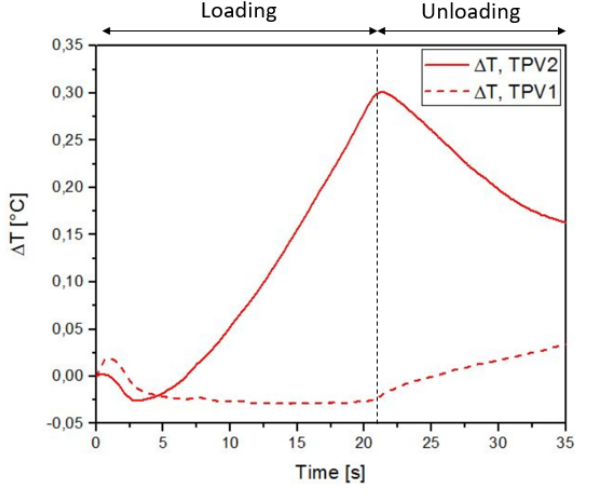
Figure 20. Temperature change with time for specimen overmoulded at 260 ◦ C, in the case of cyclic